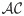
An example of AC-based HMM with 128 ACs as states for K = 2 generations (i.e. grandparents).Arrows: possible transitions along the Markov chain from site i − 1 to i. The vectors under each pedigree provide the binary representations of P, C, and R, respectively, for the pedigree. The two top thick arrows and the lower thick arrow indicate the settings of R and P, respectively.